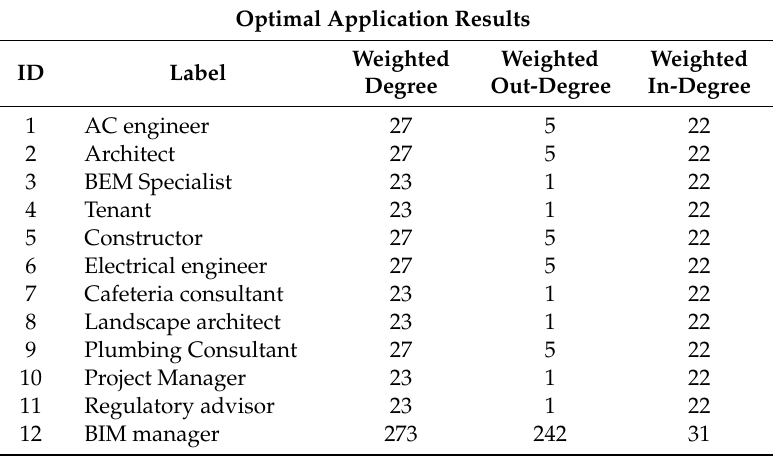
Table 2. SNA results for optimal implementation of BIM in green